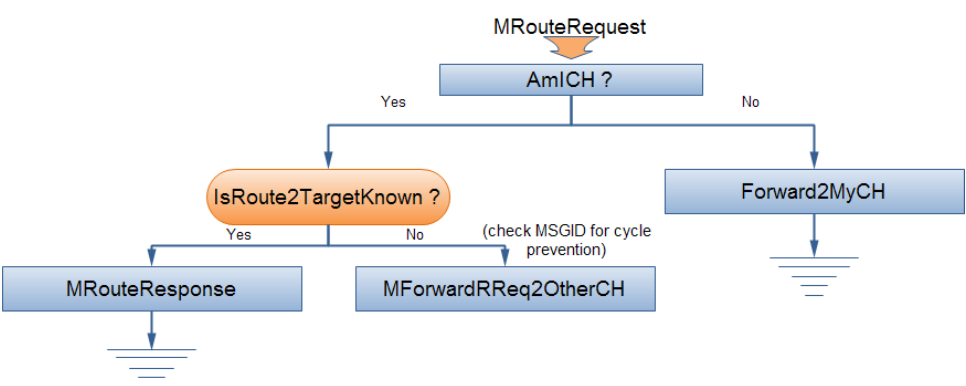
Figure 4. Routing in